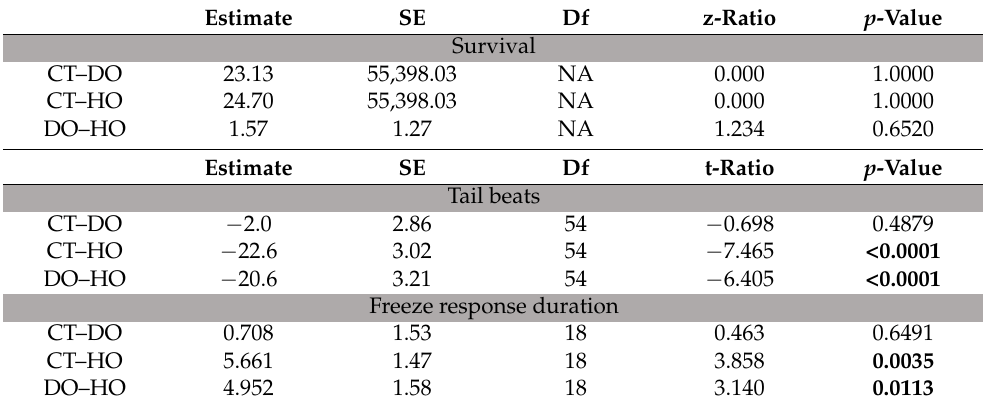
Table 2. Summary output for generalized linear models of shark embryos’ survival, average number of tail beats, and freeze response duration among control, deoxygenation, and hypoxia treatments. Statistical significance at p -value < 0.05 is shown in bold.